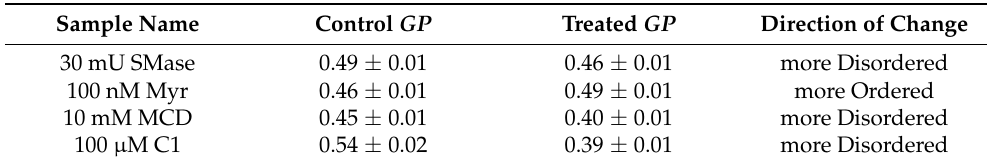
Table 2. GP values in control (non-treated) and treated samples. Errors are the intrinsic measure- ment errors.